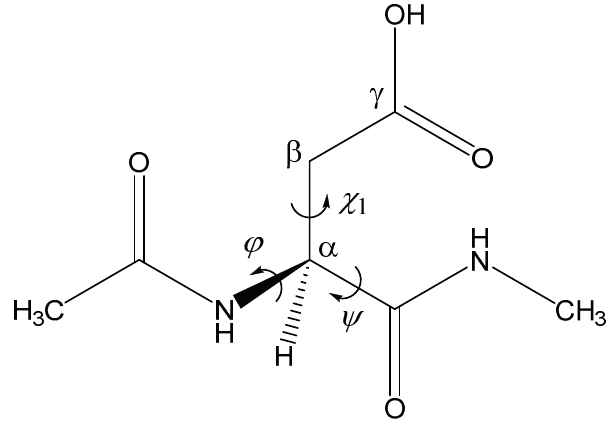
Figure 1. The model compound used in the present study (Ace-Asp-Nme). The